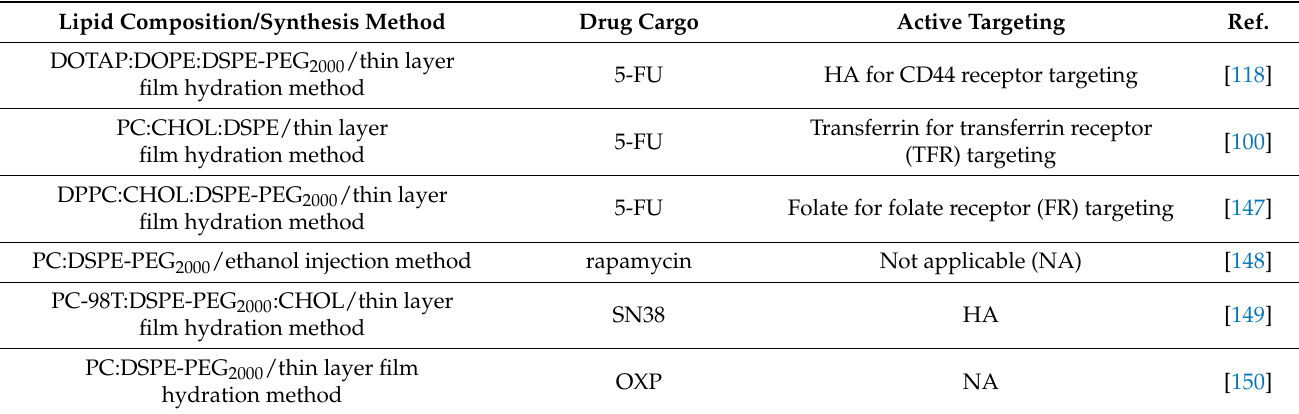
Table 2. Examples of various lipid compositions employed for liposome synthesis. Cationic lipids: DOTAP (1,2-dioleoyl- 3-trimethylammoniun-propane); zwitterionic lipids: PC (phosphatidyl choline), DPPC (1,2-dihexadecanoyl-sn-glycero- 3-phosphocholine); neutral lipids: DOPE (1,2-dioleoylsn-glycerol-3 phosphoethanolamine), CHOL (cholesterol); anionic lipids: DSPE (1, 2-distearoyl-sn-glycero-3-phosphoethanolamine-poly(ethylene glycol)). Lipid Composition/Synthesis